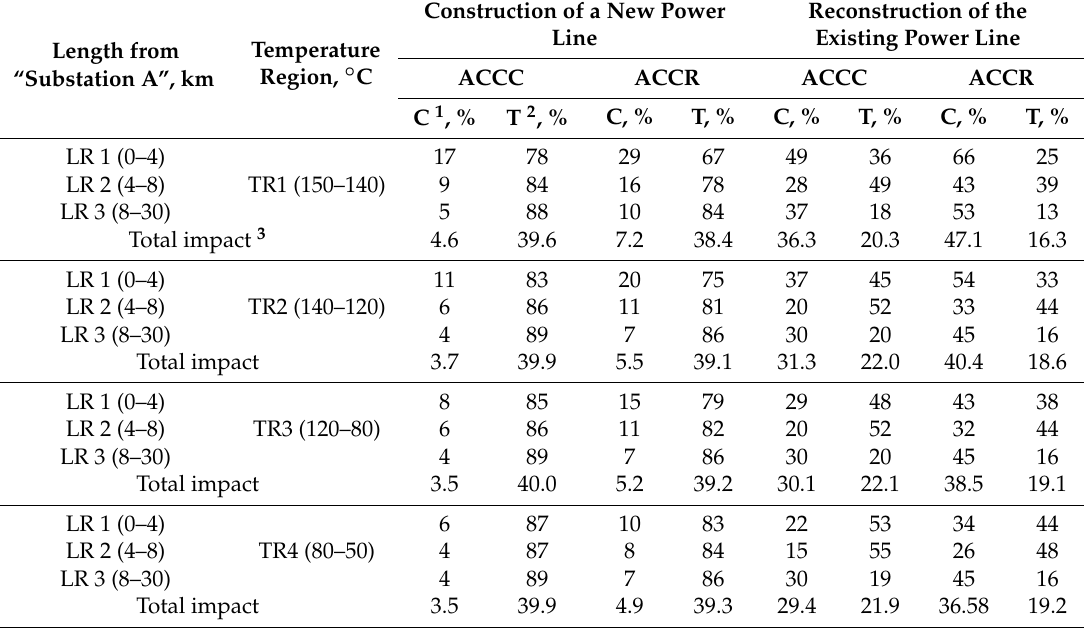
Table 10. Comparison of the effects of two main components on the total material cost and